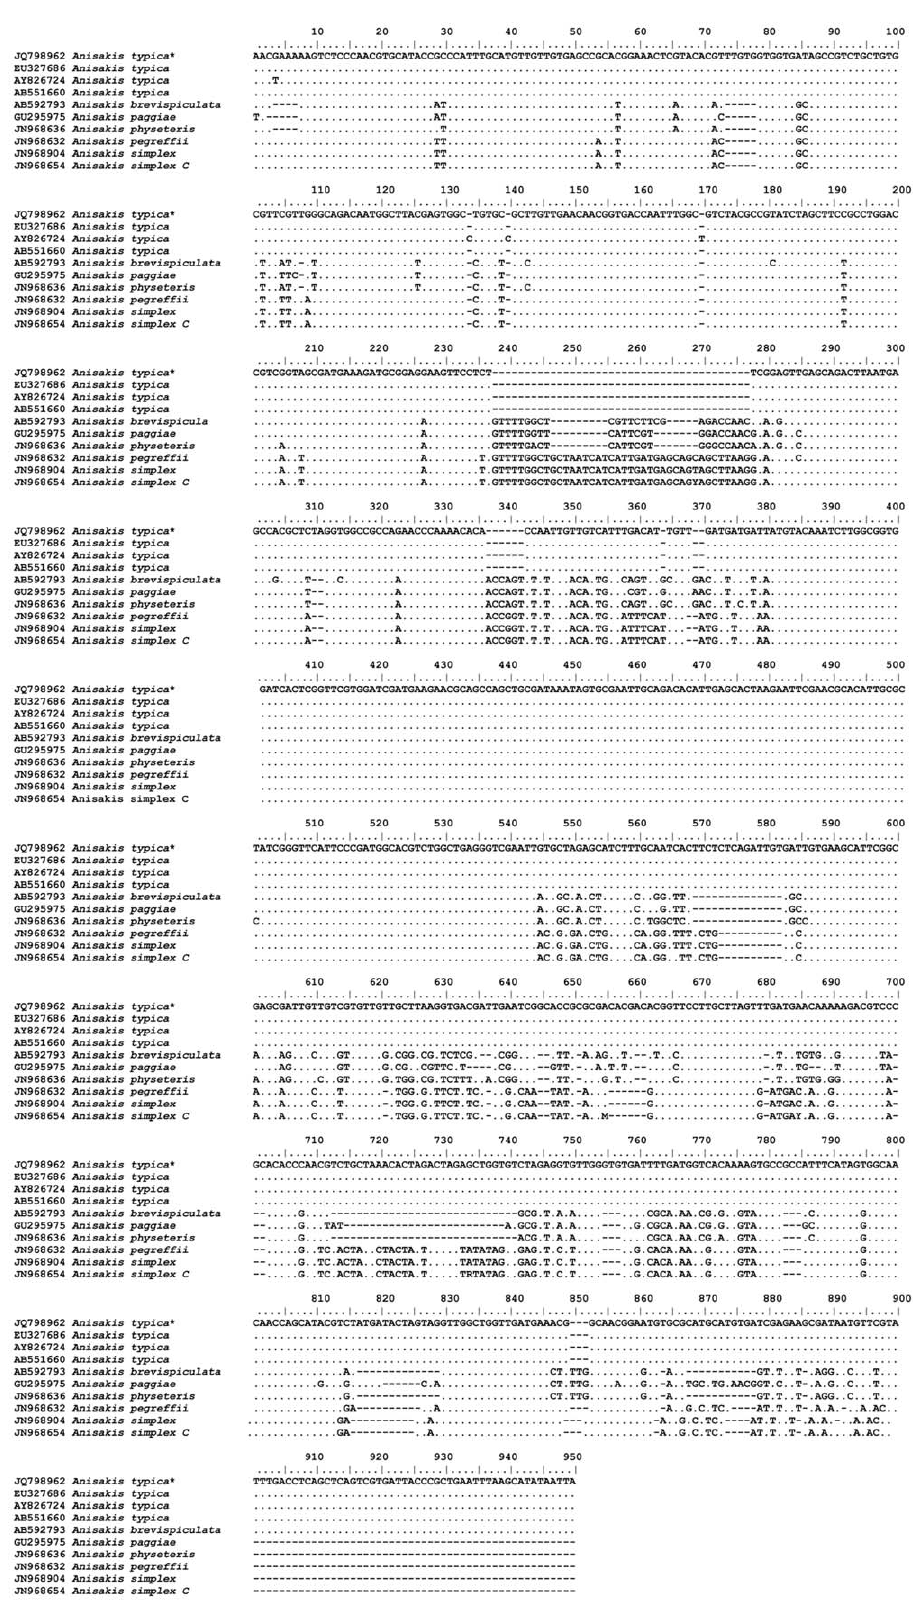
Figure 2. Alignment of ITS-1 and ITS-2 sequences representing Anisakis spp. Dots indicate identity with the first sequence, dashes are inferred insertion-deletion events and * represents our sample.